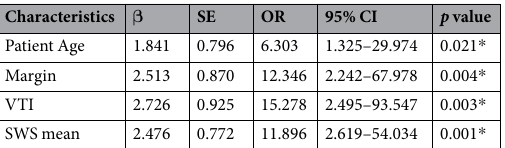
Table 3. Multivariate logistic regression analysis. β , regression coefficient; SE, standard error; OR, odds ratio; CIs, Confidence intervals; VTI virtual touch tissue imaging; SWS, shear wave speed. * Indicates statistically significant difference at the level of two-tailed 0.05.